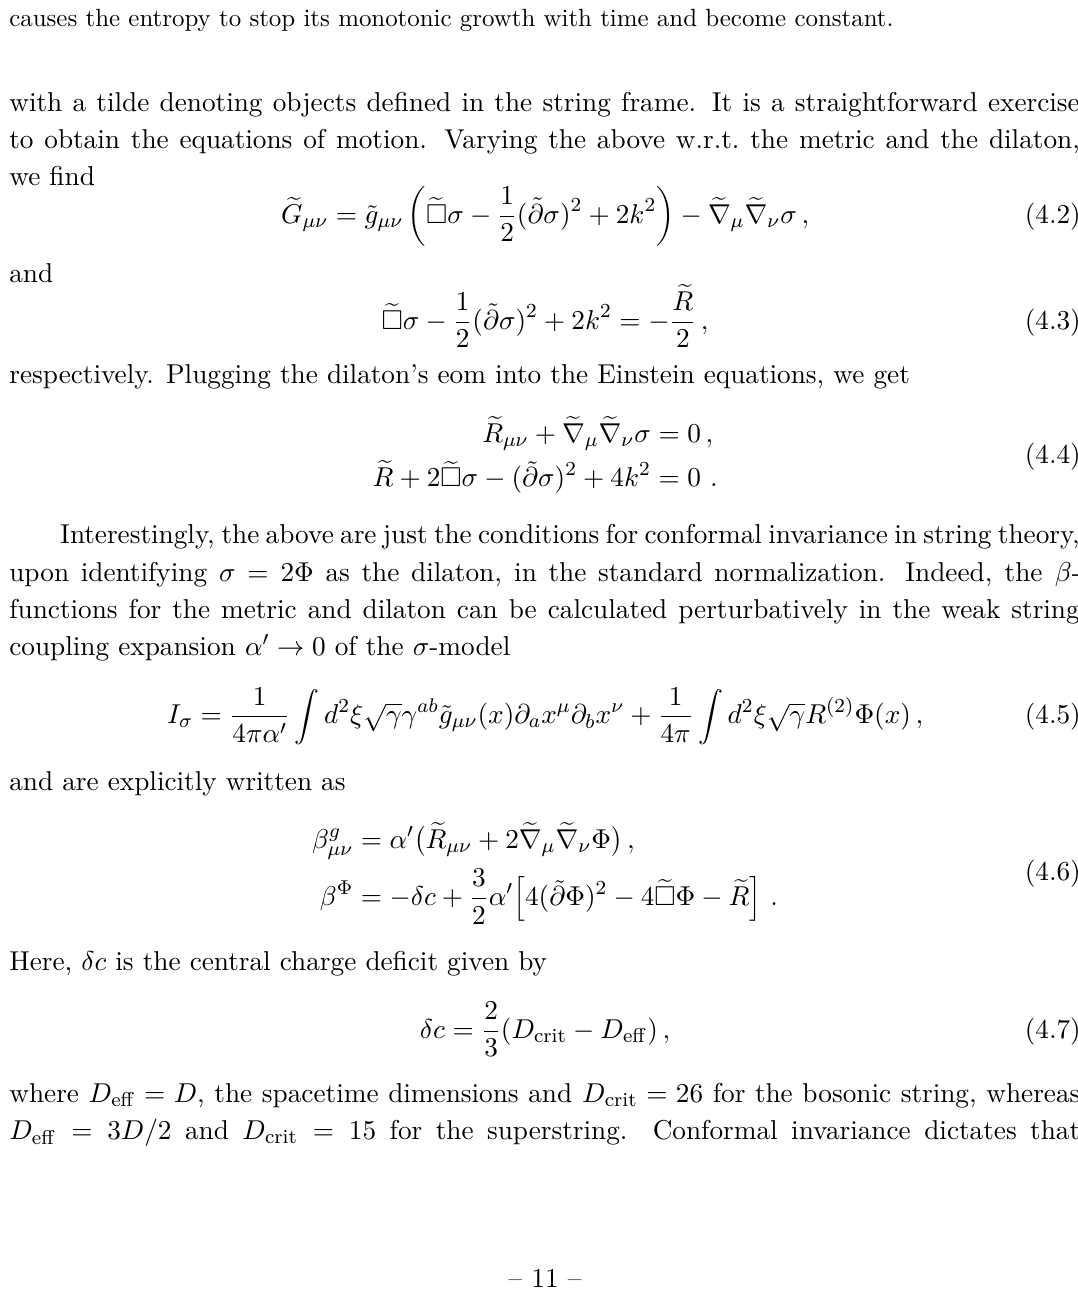
Figure 3. The (qualitative) evolution of the generalized entropy of the four-dimensional linear dilaton black hole as a function of time. At approximately Page time, the contribution of the island causes the entropy to stop its monotonic growth with time and become